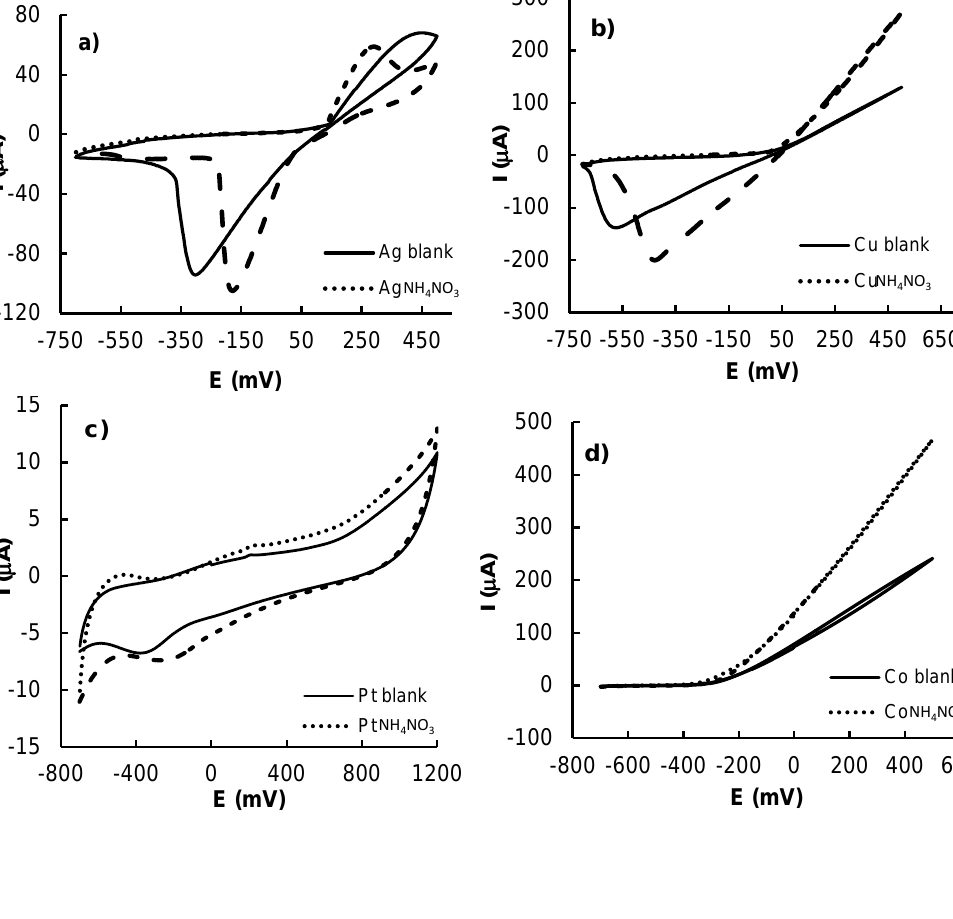
NO solutions (dashed line) 4 3